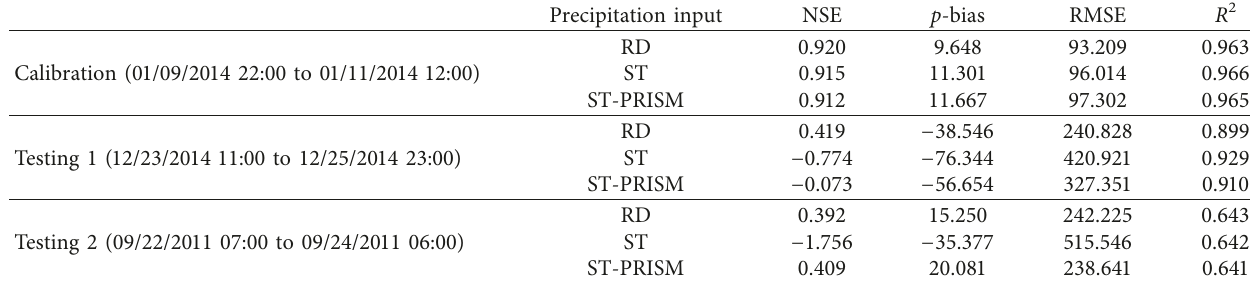
Figure 4: Observed and simulated streamflows (solid lines) in two subbasins of Waccamaw (a, c, and e for subbasin 1 and b and d for subbasin 2) using three precipitation inputs (dash lines) for calibration (a, b) and testing period(s) (c–e). ST: station observations, RD: radar data, and ST-PRISM: station observations adjusted by the gridded daily Parameter-elevation Relationships on Independent Slopes Model (PRISM) precipitation data. Table 4: Model performance in the Gills Creek